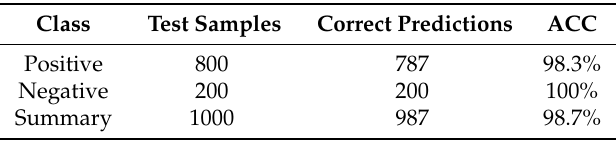
Table 1. Test accuracy (ACC) of polar-body detection.